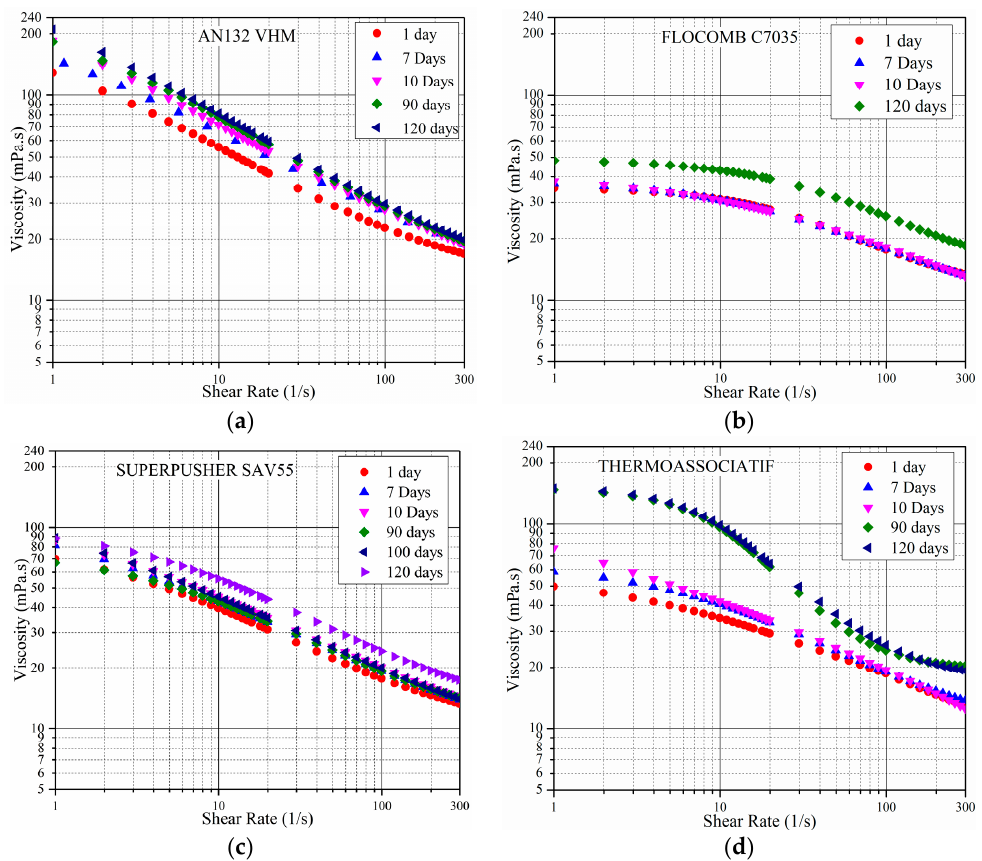
Figure 7. The viscosity as a function of shear rate measured at 25 °C for polymers in 5 wt % NaCl and 3 wt % IBA. Samples varied in aging time, ranging from 1 to 120 days at 80 °C.